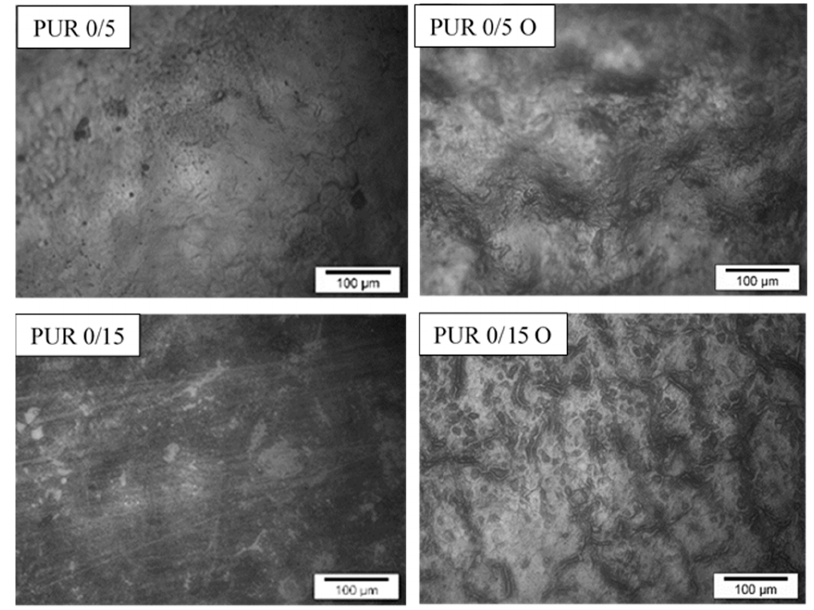
Figure 9. Microscopic micrographs of PUR 0/5 samples before and after 11 weeks of incubation in the oxidizing solution.